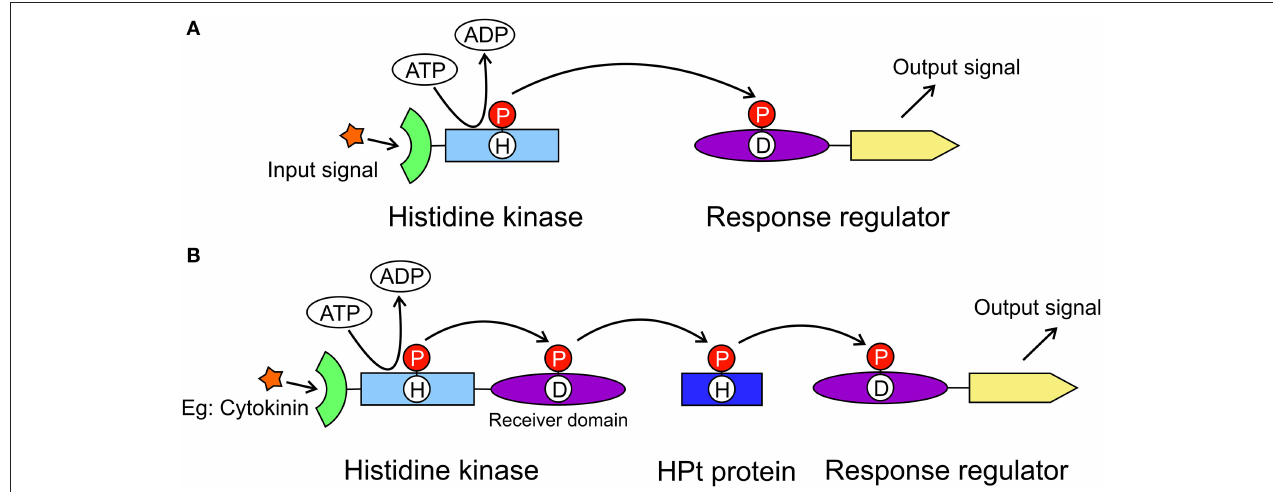
FIGURE 1 | General models of the two-component system and the multistep phosphorelay system. The two-component system (A) is utilized in prokaryotes to transduce signals by a phosphorylation reaction. It includes a histidine kinase and a response regulator. The histidine kinase has an extracellular signal sensing domain (green) and a transmitter domain (light blue) where a conserved His residue will autophosphorylate. The phosphate group (red circle) is then transferred to the receiver domain (purple) of the response regulator resulting in the output signal from the effector domain (yellow). The multistep phosphorelay system (B) has evolved from the two-component system, in which the histidine kinase has an additional receiver domain. The multistep phosphorelay also has a histidine-containing phosphotransfer protein (dark blue) as the shuttle between the kinase and the response